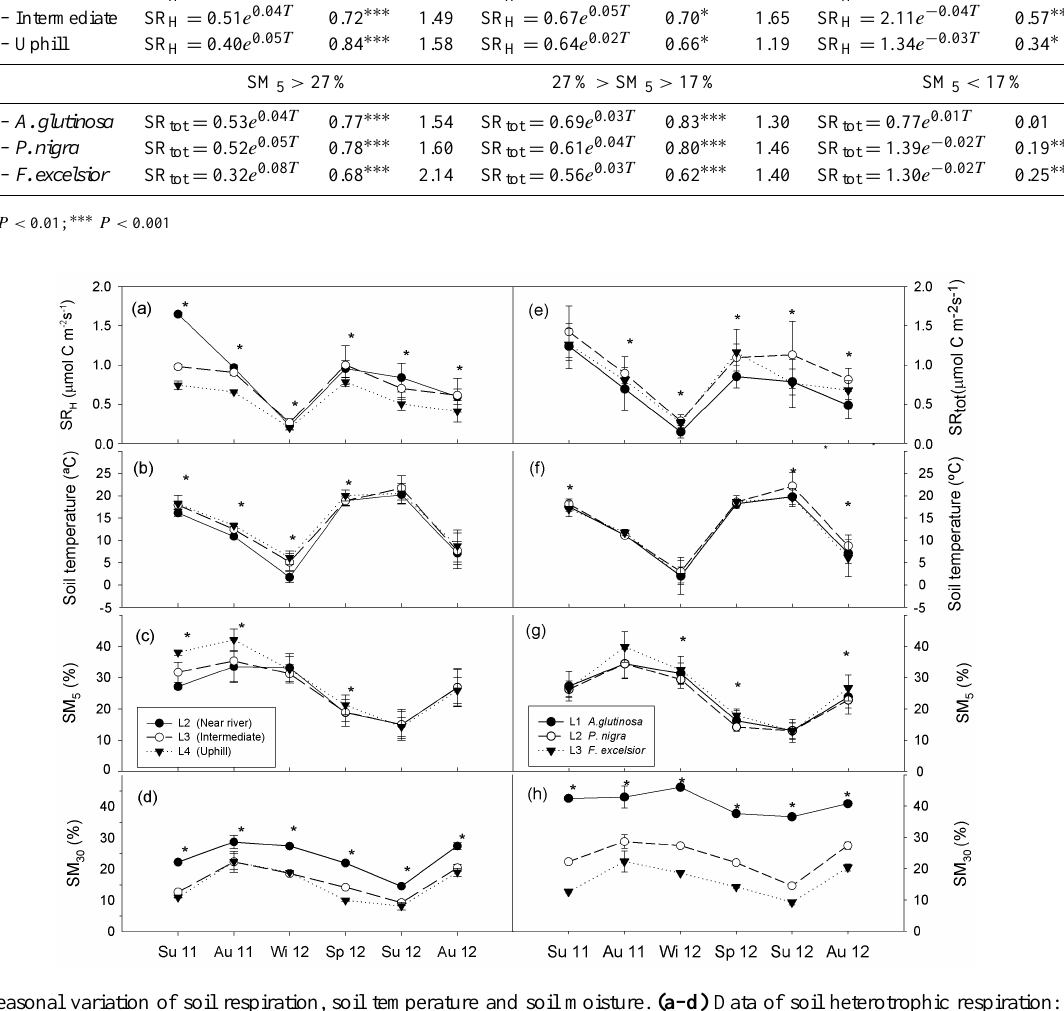
Figure 3. Seasonal variation of soil respiration, soil temperature and soil moisture. (a–d) Data of soil heterotrophic respiration: (a) SRH along groundwater level gradient. (b) 5cm soil temperature. (c) 5cm integral soil moisture (SM 5 ). (d) 30cm integral soil moisture (SM 30 ). (e–h) Data of total soil respiration rates (SRtot) of three tree species. (e) SR tot under different tree species. (f) 5cm soil temperature. (g) 5cm integral soil moisture (SM 5 ). (h) 30cm integral soil moisture (SM 30 ) . All values are mean SD. Data points marked with indicate significant differences between species at P < 0 . 05 (For details, please see to Appendices A and